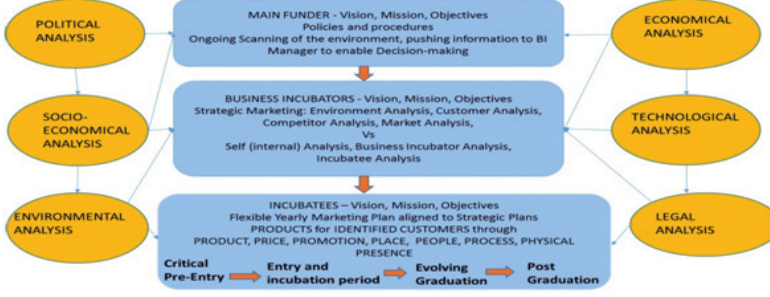
Fig. 8 – Strategic Marketing snapshot for Business Incubators. Source: